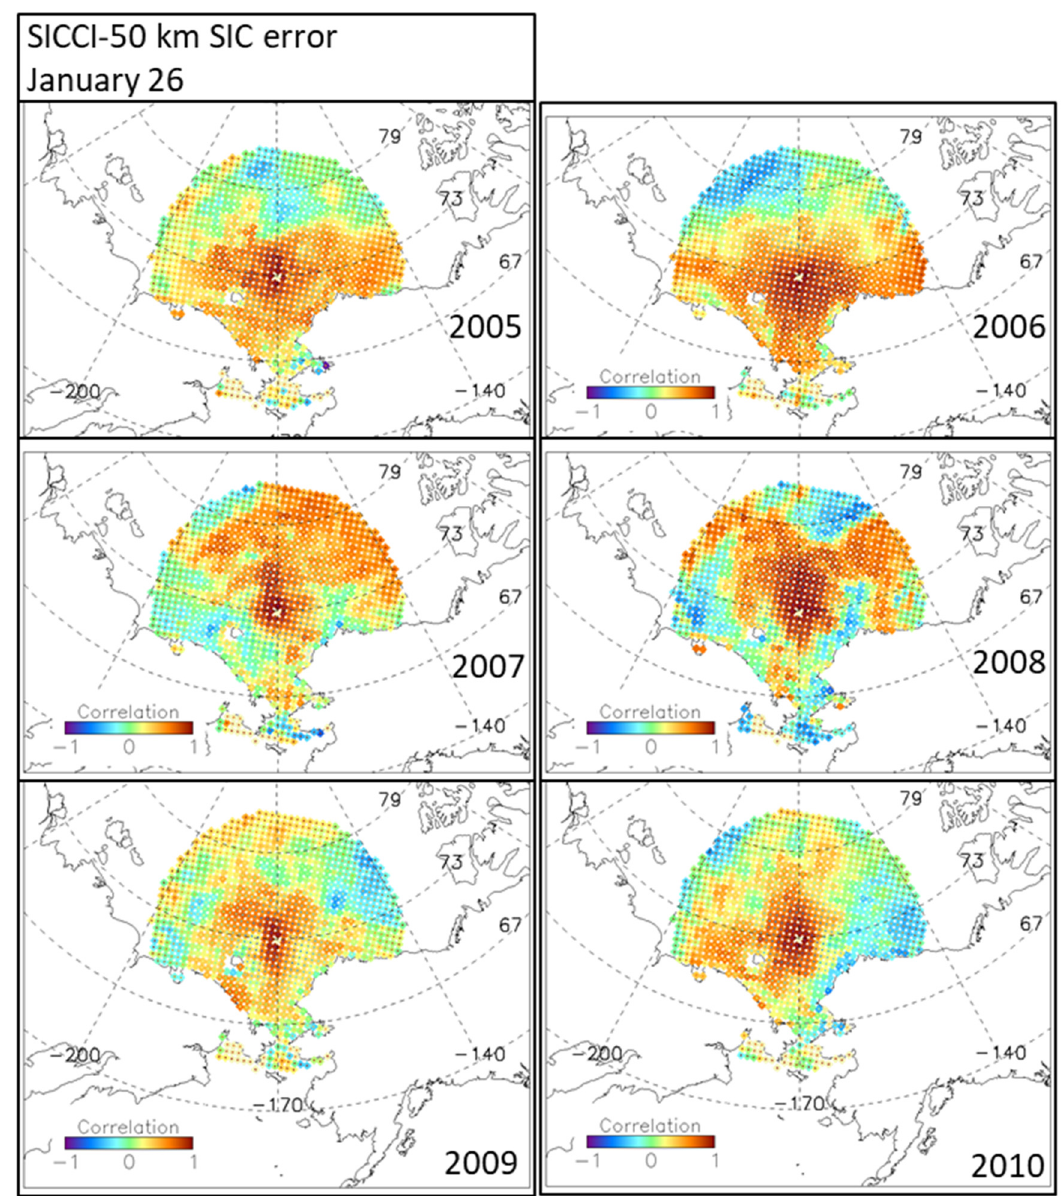
Figure 8. Correlation discs obtained for the SICCI-50km SIC error for 26 January of years 2005 through 2010 in the area north of the Bering Strait shown in Figure 3a.